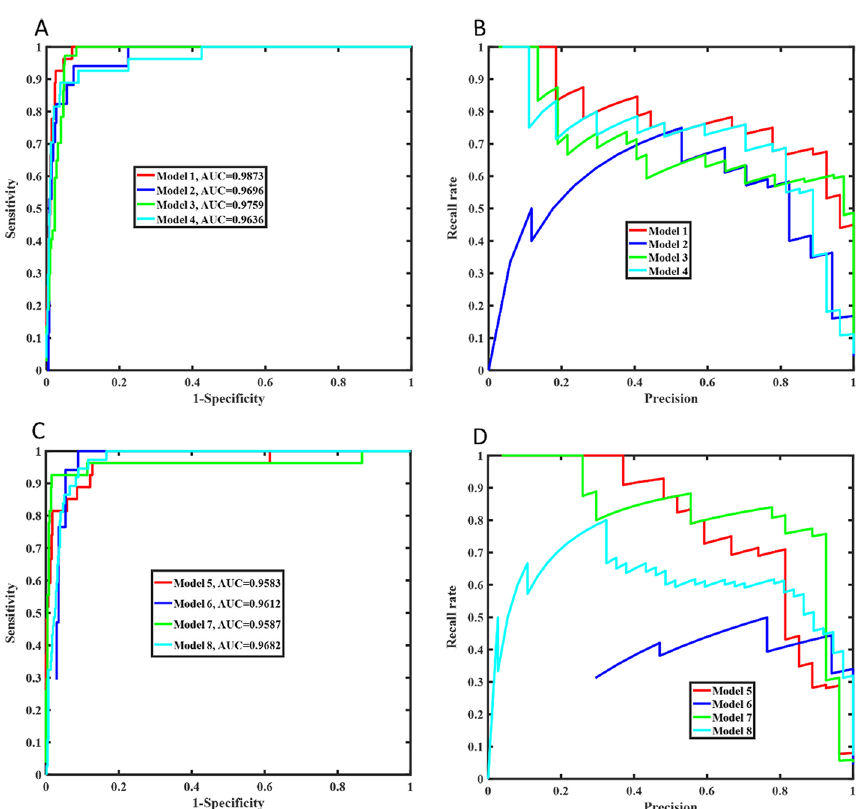
Fig. 4 Performance of models in cross validation. A , B Epoch Model 2: ResNet50; Model 3: InceptionResNetV2; Model 4: InceptionV3; Model 5: ResNet101; Model 6: ResNet50; Model 7: InceptionResNetV2; Model 8: